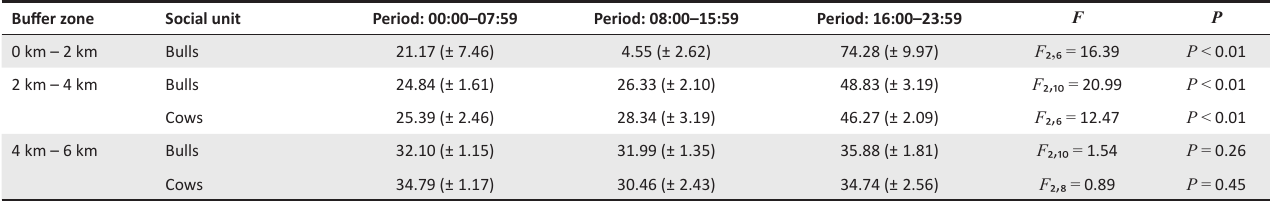
TABLE 2: Proportion of elephant location points during three periods across the buffer zones surrounding villages in Mozambique’s Limpopo National Park and villages bordering the Limpopo River of South Africa’s Kruger National Park (± standard error). Buffer